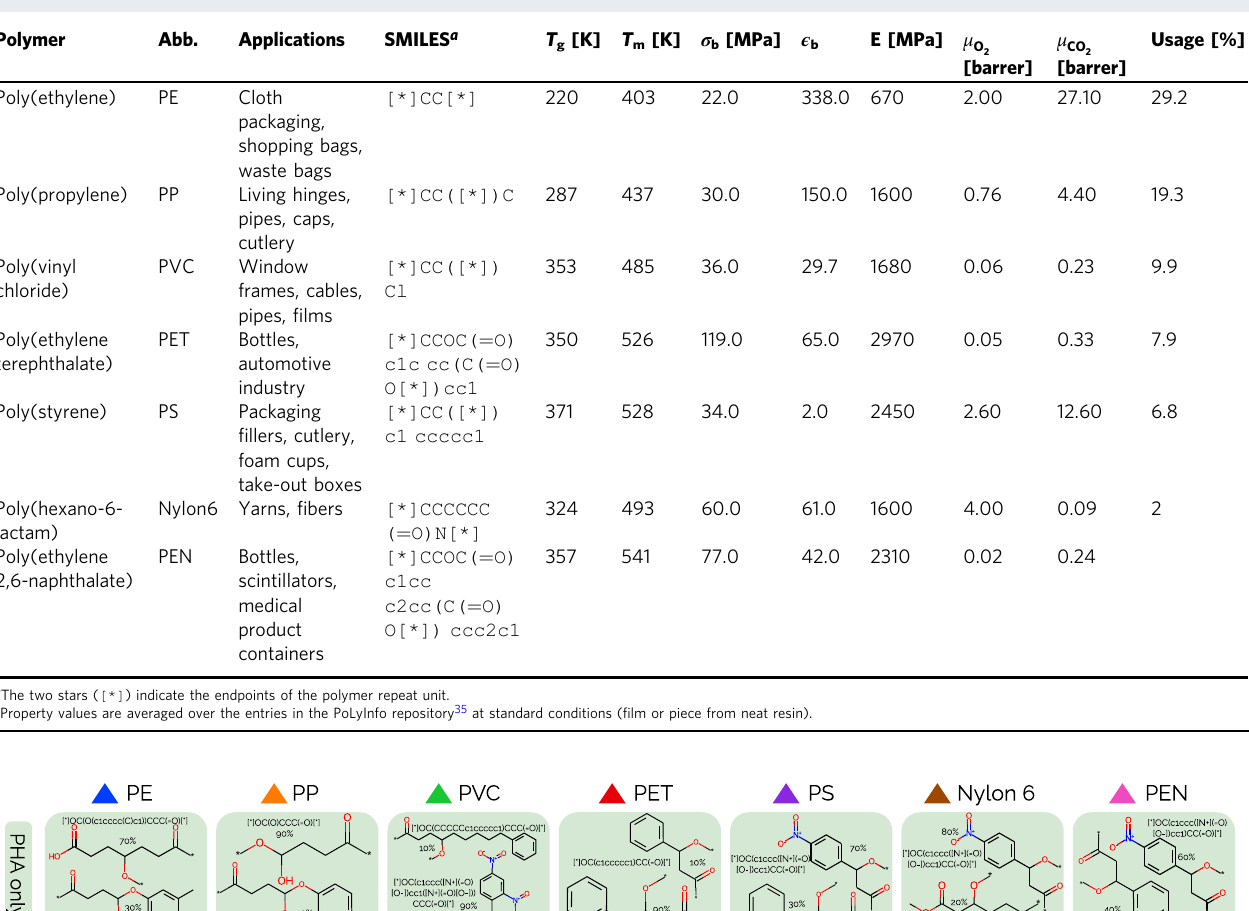
Table 3 Measured properties of petroleum-based commodity plastics that in total account for 75.1% of Europe ’ s yearly plastic production in 2019 (see usage column) 2 .